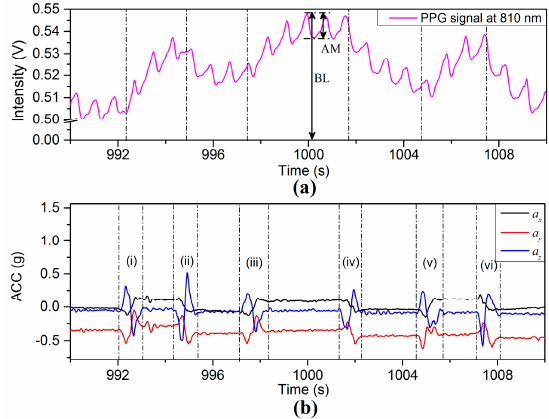
Figure 5. Enlarged portion of Figure 4 in the interval 1290–1310 s: ( a ) PPG and ( b ) ACC signals.